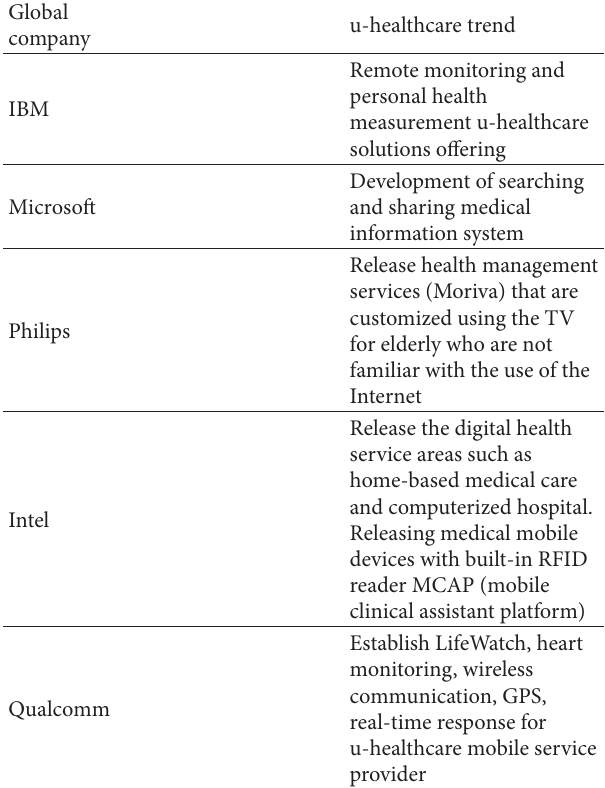
Table 1: u-healthcare trend of global